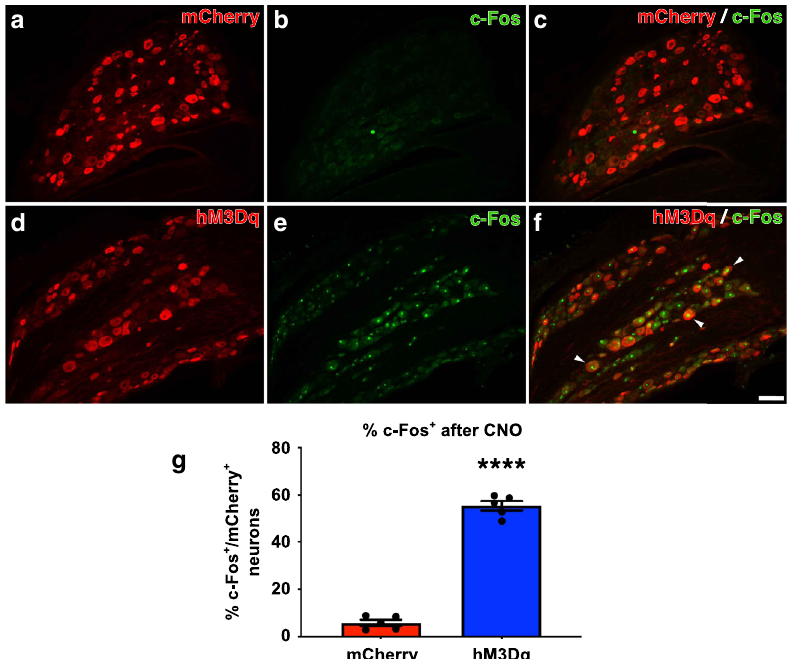
Fig. 3 CNO administration activates adult, hM3Dq + DRG neurons in vivo. AAV5-hSyn-hM3Dq-mCherry or AAV5-hSyn-mCherry was injected into the right C5-C8 DRGs. Four weeks later, CNO was subcutaneously injected into all animals. Two hours later, animals were perfused and DRG sections were stained for the mCherry reporter and c-Fos, an established marker of neuronal activation ( a – f ). Very few neurons transduced with AAV-mCherry expressed c-Fos ( a – c ) while many hM3Dq + neurons expressed c-Fos ( d – f , arrowheads). g Quanti fi cation of the percent of mCherry + neurons that are also c-Fos + after CNO administration. These data con fi rm that subcutaneous CNO injection chemogenetically activated hM3Dq + neurons in vivo. N = 5